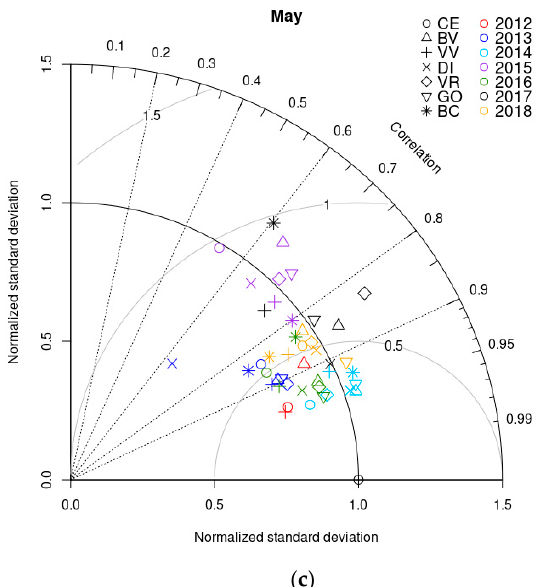
Figure 3. Taylor diagram for daily temperature in ( a ) March, ( b ) April, and ( c ) May for selected locations during 2012–2018.